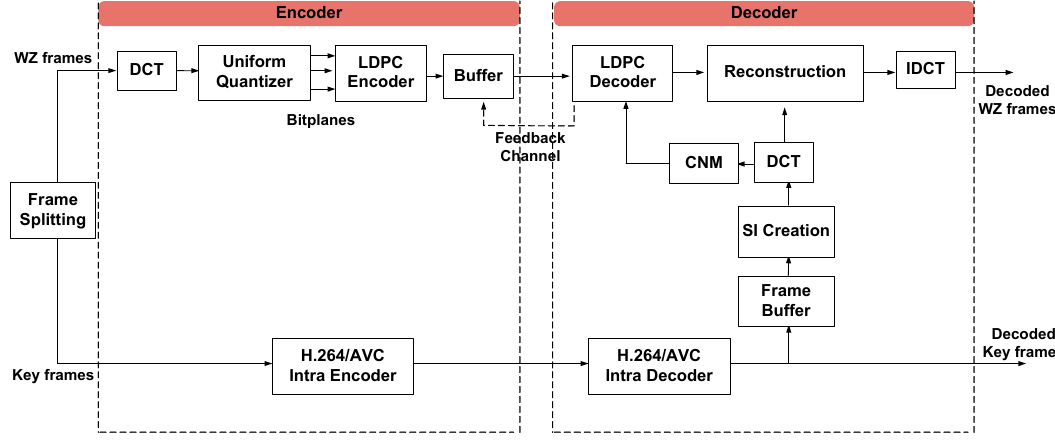
Figure 1. DISCOVER distributed video coding (DVC) architecture.